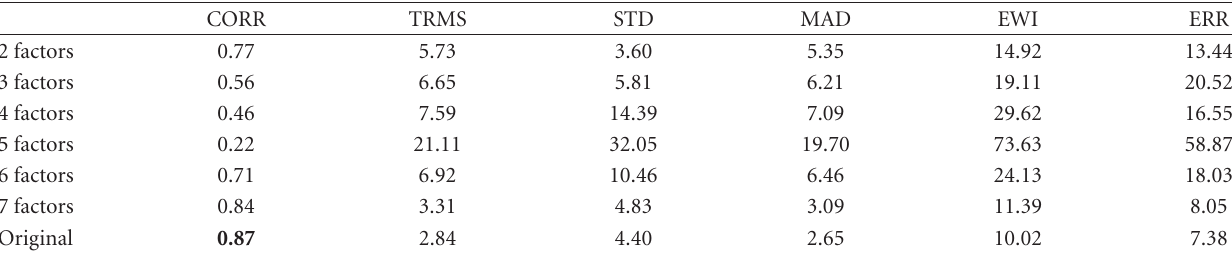
Table 5: ANFIS function analysis using the MATLAB